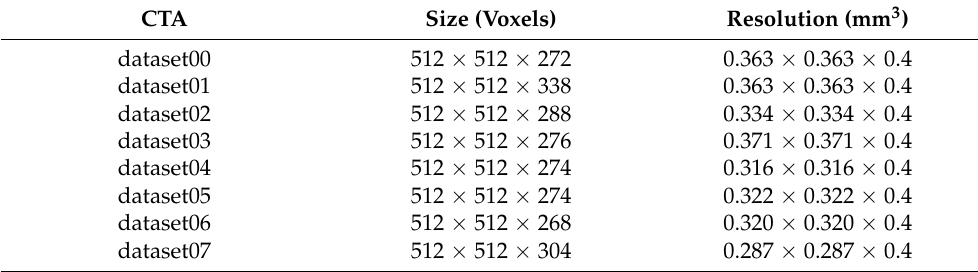
Table 1. The size and resolution of each CTA volume from the training